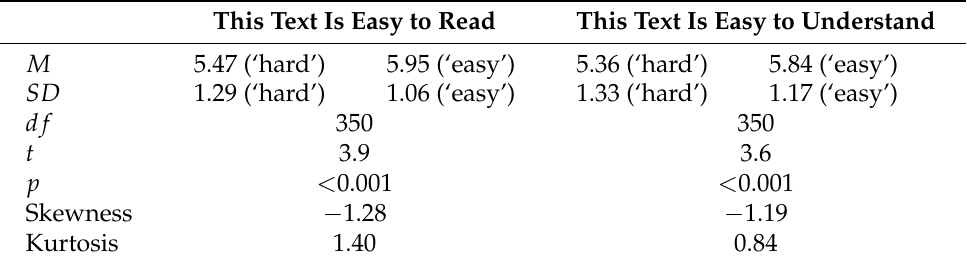
Table 3. t -Test results comparing readability metrics with perceived readability and corresponding descriptive statistics.